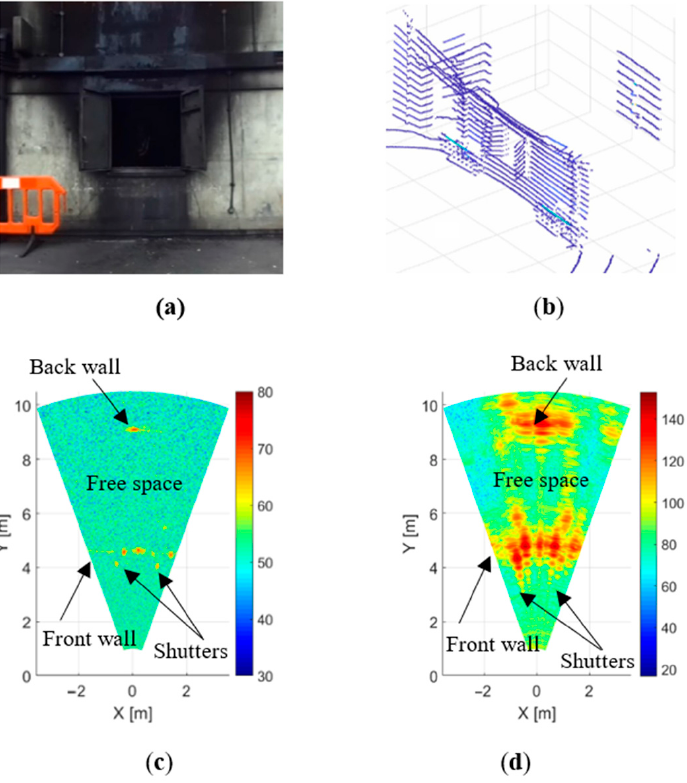
Figure 3. Measurement of empty scene with no flame, smoke or steam: ( a ) camera, ( b ) LIDAR, ( c ) 300 GHz radar and ( d ) 79 GHz radar.